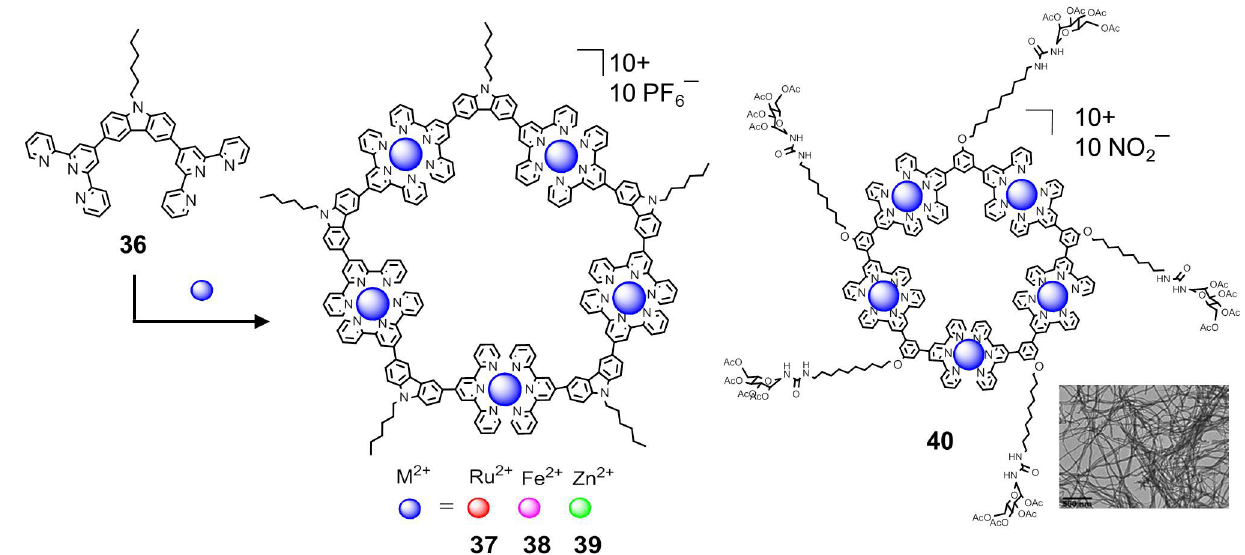
FIGURE 17 – Carbazole-based rings showed promise as sensitizers and sugar-coated rings self-assemble to form fibers [Hwang, S.-H.; Wang, P.; Moorefield, C. N.; Godinez, L. A.; Manriquez, J.; Bustos, E.; Newkome, G. R. Chem. Commun. , p.4672-4674, 2005. - Reproduced by permission of The Royal Chemistry Society; Chan, Y.-T.; Moorefield, C. N.; Soler, M.; Newkome, G.